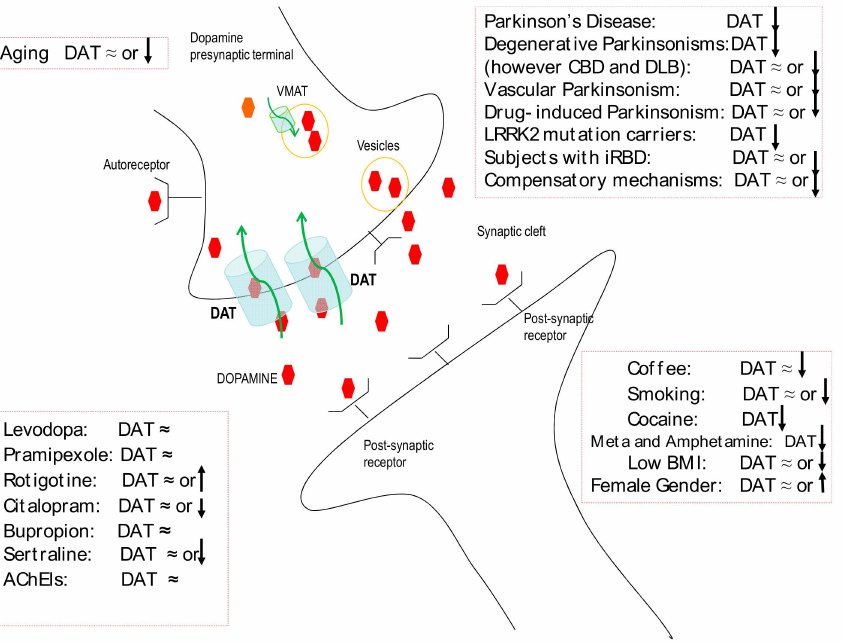
Figure 1. Schematic representation of a dopamine synapse with the dopamine transporter (DAT) and its interference by both external and disease-related factors. (AChEIs: acetylcholinesterase inhibitors; BMI: body mass index; iRBD: idiopathic REM sleep behavior disorder; LRRK2: leucine-rich repeat kinase 2; and VMAT: vesicular monoamine